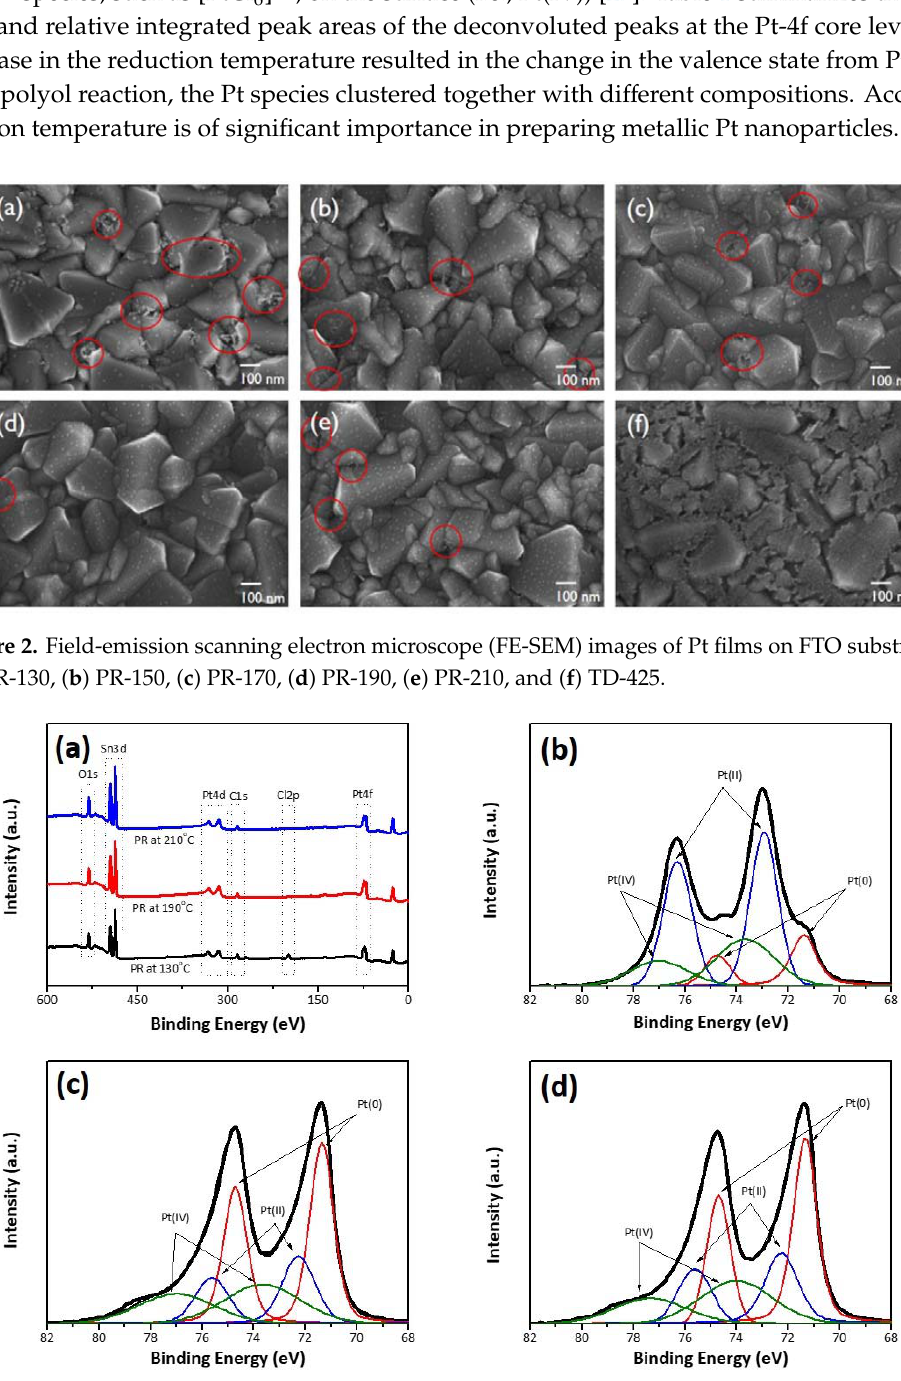
Figure 3. X-ray photoelectron spectroscopy (XPS) scans of polyol-reduced Pt on FTO substrates: Figure 3. X ‐ ray photoelectron spectroscopy (XPS) scans of polyol ‐ reduced Pt on FTO substrates: ( a ) ( a ) survey, ( b ) PR-130, ( c ) PR-190, and ( d ) survey, ( b ) PR ‐ 130, ( c ) PR ‐ 190, and ( d ) PR ‐ 210. Table 1. Binding energies (eV) and relative proportions (S, in %) of each component measured by XPS.